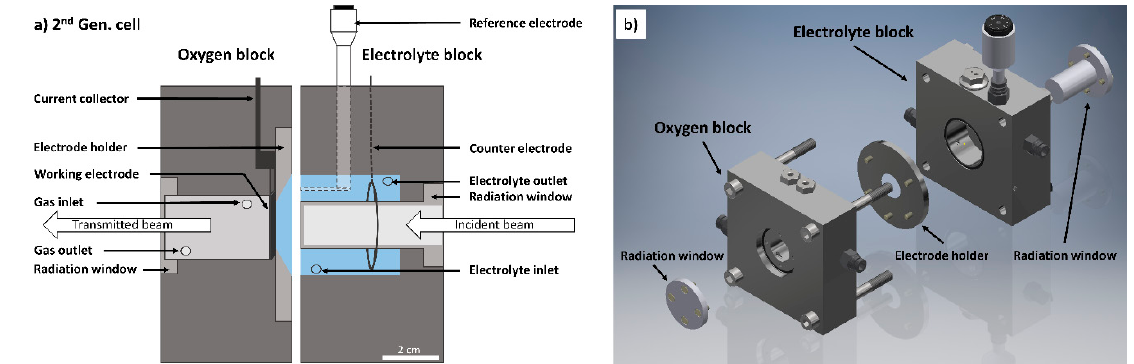
Figure 5. ( a ) Schematic diagram of second generation (2 nd Gen.) cell with relevant parts; ( b ) 3D-cell design of 2 nd Gen. cell.